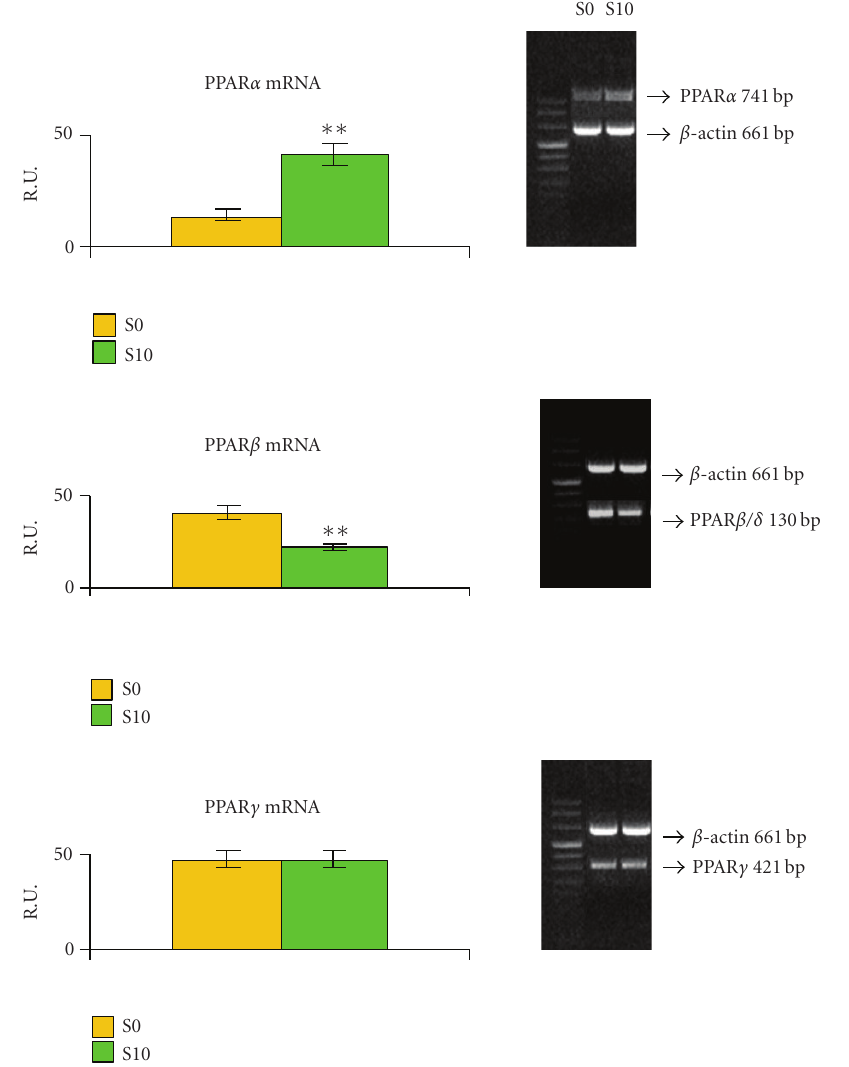
Figure 8: RT-PCR analysis in S0 and S10 neurospheres. An example of RT-PCR is shown. Densitometric data are means ± SD of 5 di ff erent experiments. Semiquantification has been performed against the housekeeping gene β -actin. ∗∗ , P < . 001.